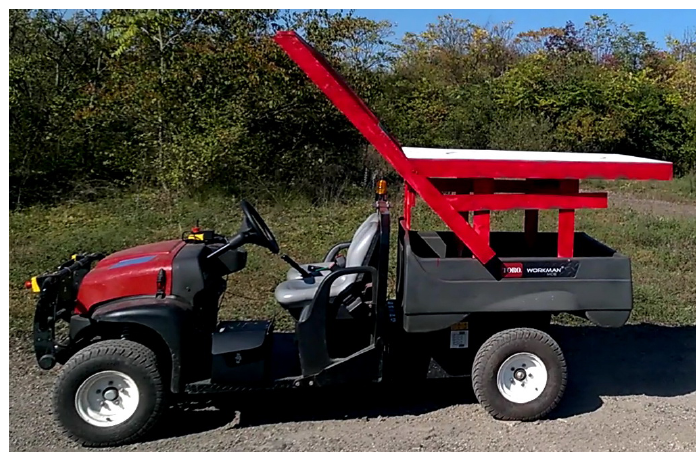
Figure 9. The Toro Workman ground vehicle used for our tests.